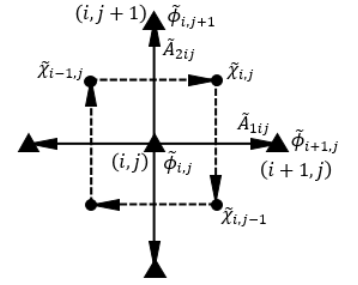
Figure 12 . Dual lattice: the scalar (cid:12)eld operator ~ (cid:31) is in the center of the plaquette and operator ~ (cid:30) is in the vertex. The gauge (cid:12)eld operator ~ A in some link is equal to a di(cid:11)erence of scalar (cid:12)eld operators ~ (cid:31) across the link in the dual lattice which is perpendicular to the one corresponding to ~ A plus a di(cid:11)erence of scalar (cid:12)eld operators ~ (cid:30) along the same link in the dual lattice. The duality of gauge (cid:12)eld momentum operator (cid:25) is in the same